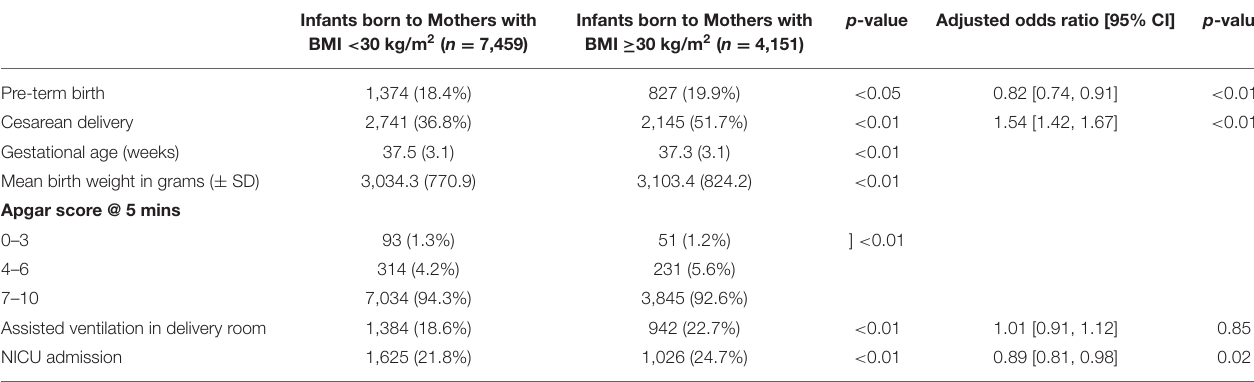
TABLE 2 | Delivery characteristics and outcomes of infants born to mothers without and with